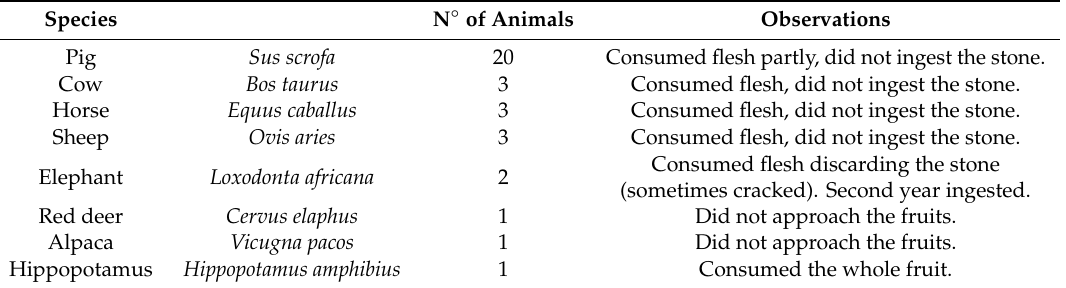
Table 3. Animal species presented with fruits of Gomortega keule . All species were presented 100 fruits. The table shows whether and how animals handled the